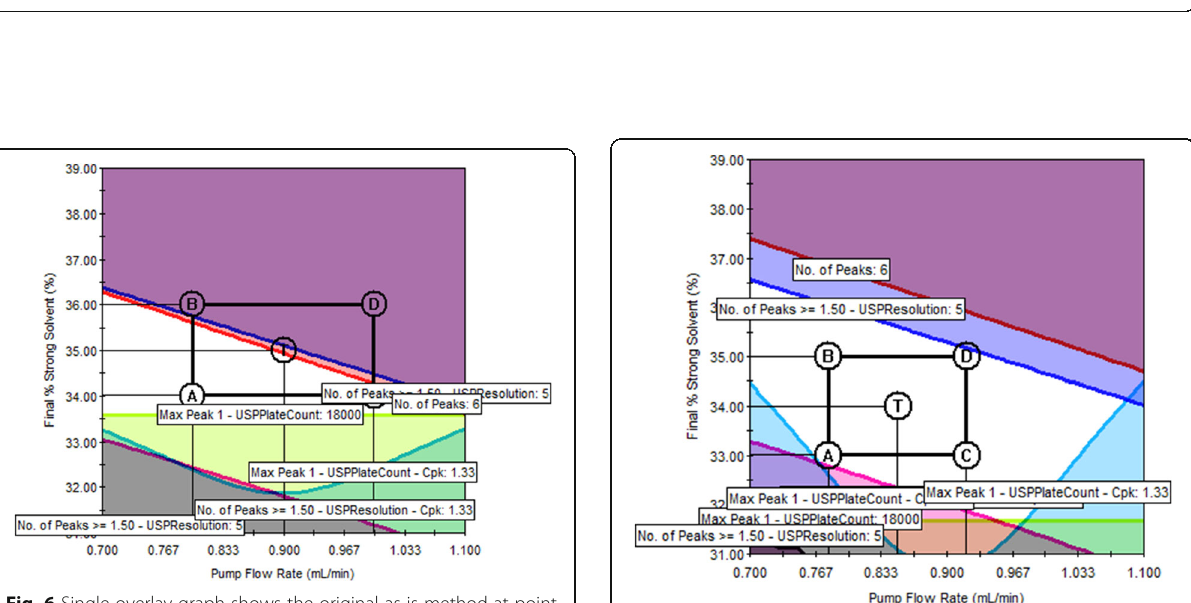
Fig. 5 Trellis overlay graph shows how the size of the MODR (unshaded area) changes as the four method parameters change